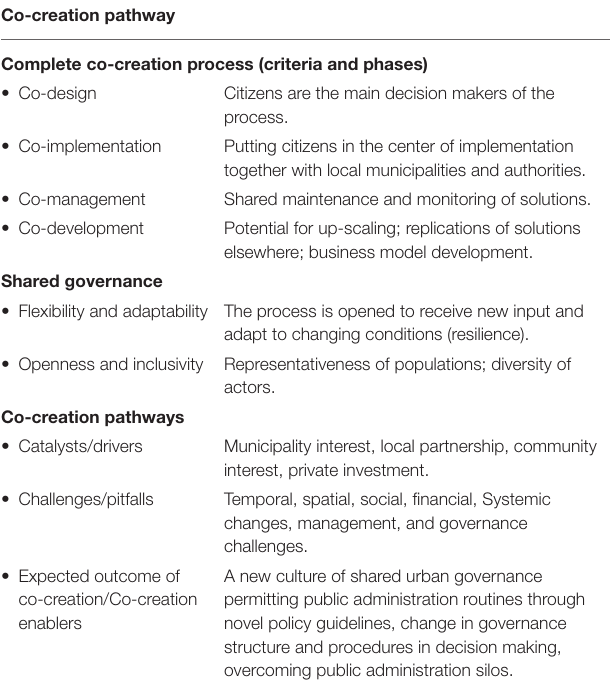
TABLE 3 | Co-creation pathway phases, challenges, enablers, and outcomes. Co-creation pathway Complete co-creation process (criteria and